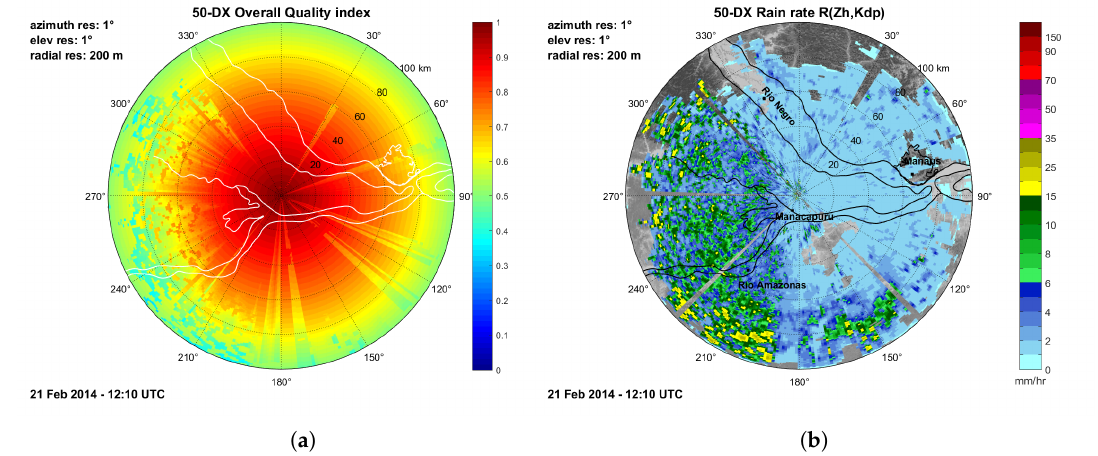
Figure 10. ( a ) Overall radar quality index and ( b ) Rain rate from radar on 21 February 2014 at 12:10 UTC. For H02, one overpass for the case which occurred on 8 March 2014 (at 05:30 UTC) is shown. Convective cells are visible along the border of the Rio Negro River, followed by smaller convective cells over the Southeast quadrant (Figure 12). Figure 13a,b show that the H02 algorithm provides precipitations from light to moderate values (shades of green) in pixels where the radar detects absence of precipitation (gray pixels). This tendency to produce a large area of precipitating pixels is related to the precipitation screening, which is the algorithm module where potential precipitating pixels are selected. This feature is related to the relatively high FAR scores (shown in Table